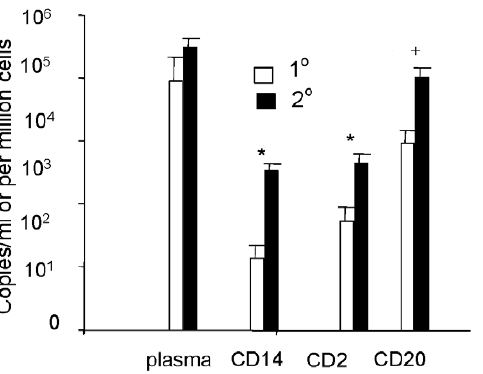
Figure 2. DENV RNA levels in plasma and PBMC subpopula- tions in primary and secondary infections. Plasma and PBMC cell subpopulations of 11 primary and 15 secondary DENV infections, all of whom had DF, were analyzed. * indicates statistically significant differences in DENV RNA levels between primary and secondary infection (P , .05). + indicates differences between DENV RNA levels in CD20 + cells compared to CD14 + and CD2 + cells (P , .05).